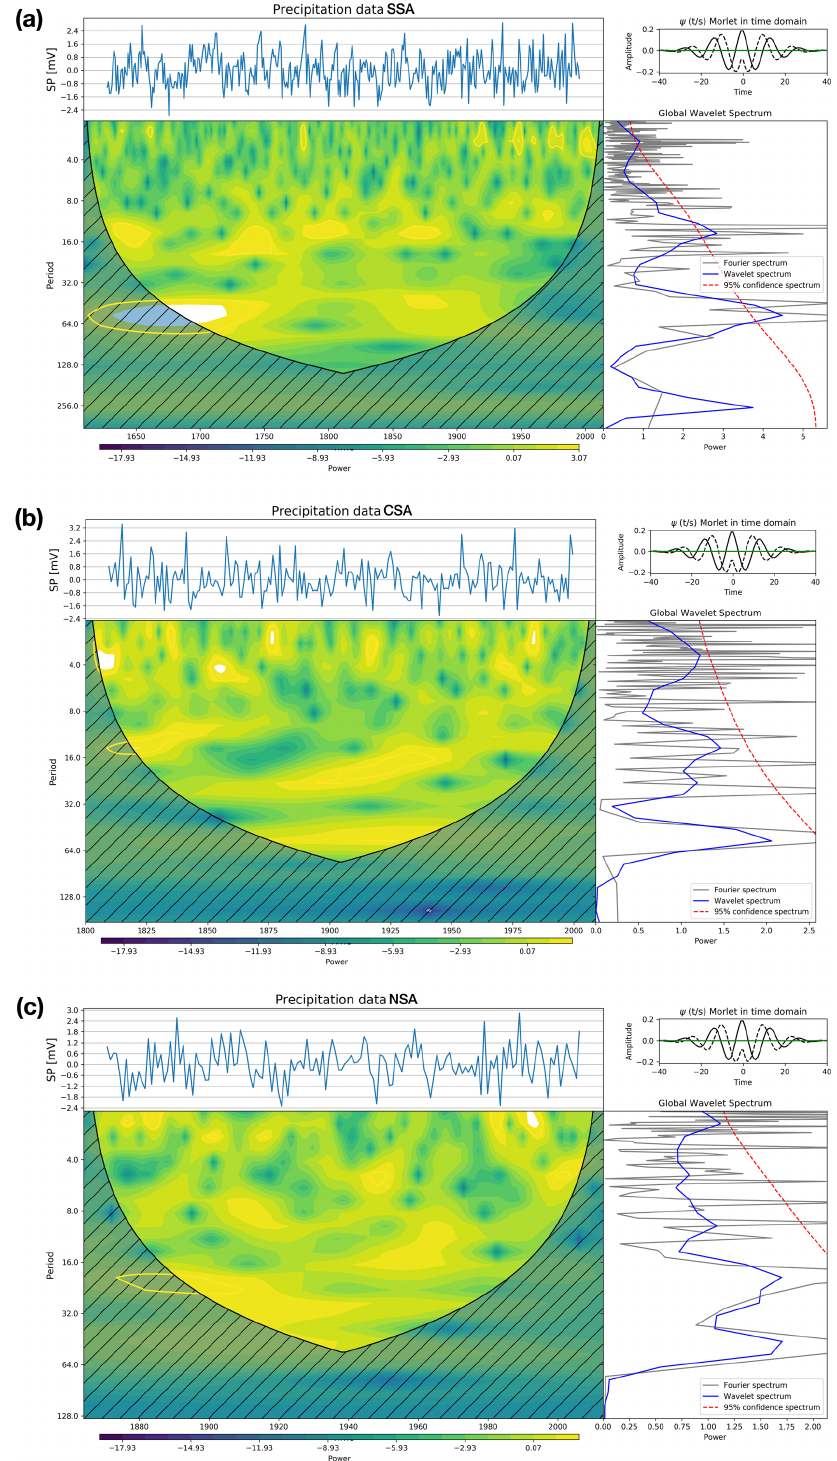
Figure 7. The wavelet power spectrum of the reconstructed precipitation at the SSA (a) , CSA (b) and NSA (c) ; powers are given in log 2 - scale. Significant are the periods that intersect the dashed red region of significance (blue curve) in the graph on the right, constructed for a significance level of 0.05. At the top of the graph is a time series and to the right is the view of the mother wavelet used. The influence cone is indicated by hatching on the wavelet transform graph (this graph is filled). Values falling into the hatched region could be affected by the continuation of the signal due to its artificial periodization beyond the interval of its actual